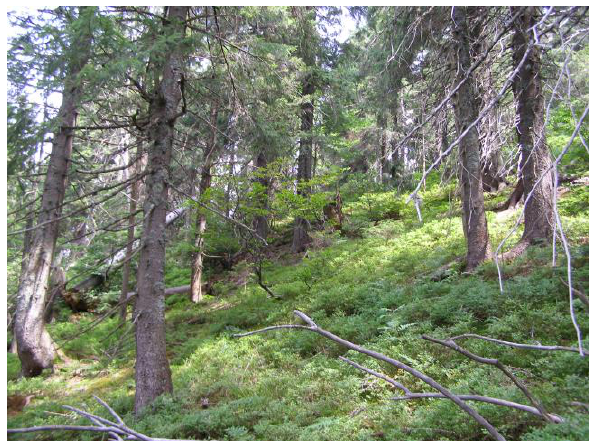
Fig. 3. Acidophilous beech-spruce forest in Synevyr National Nature Park (photo by P.M.